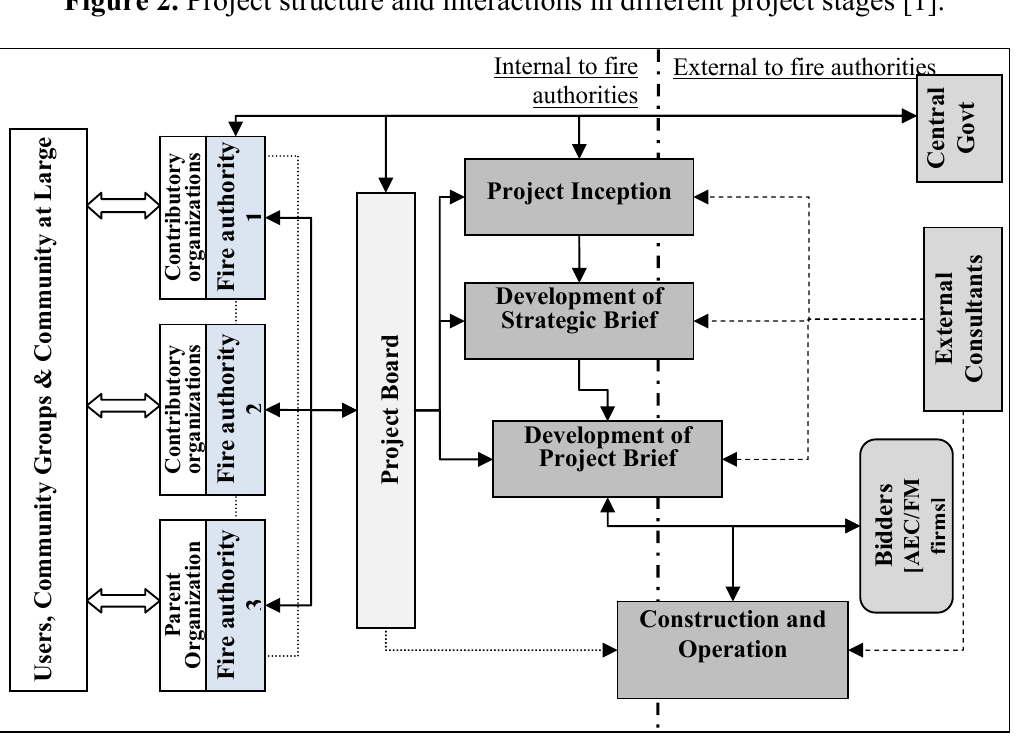
Figure 2. Project structure and interactions in different project stages